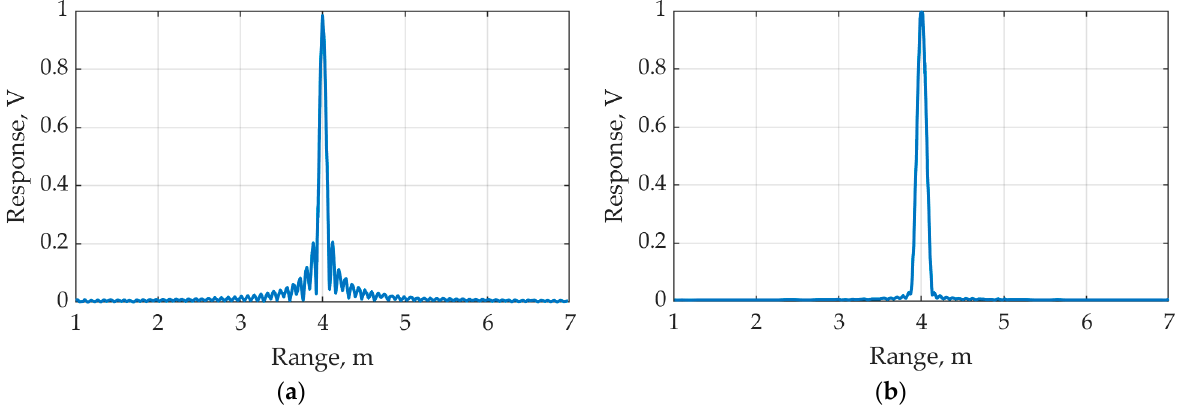
Figure 2. Normalized response functions of a point target when using a rectangular window ( a ) and a Kaiser window ( b ).